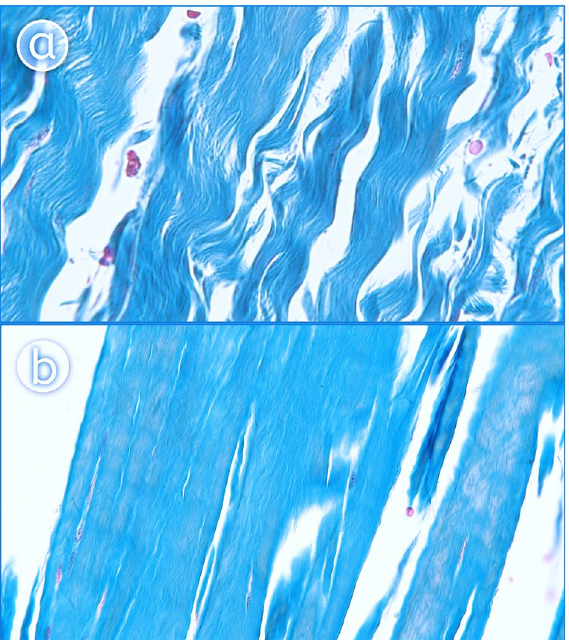
Figure 5. Histological examination of the accessory bands of the popliteus muscle. A 400 magnification— ligament. B 400 × magnification—tendon. The Fig. 5 was taken with Olympus EP50 camera (Olympus Corporation Japan), and the signatures were made in Corel DRAW 12 (https:// www. corel draw. com/ pl/ pages/ corel draw- 12/).